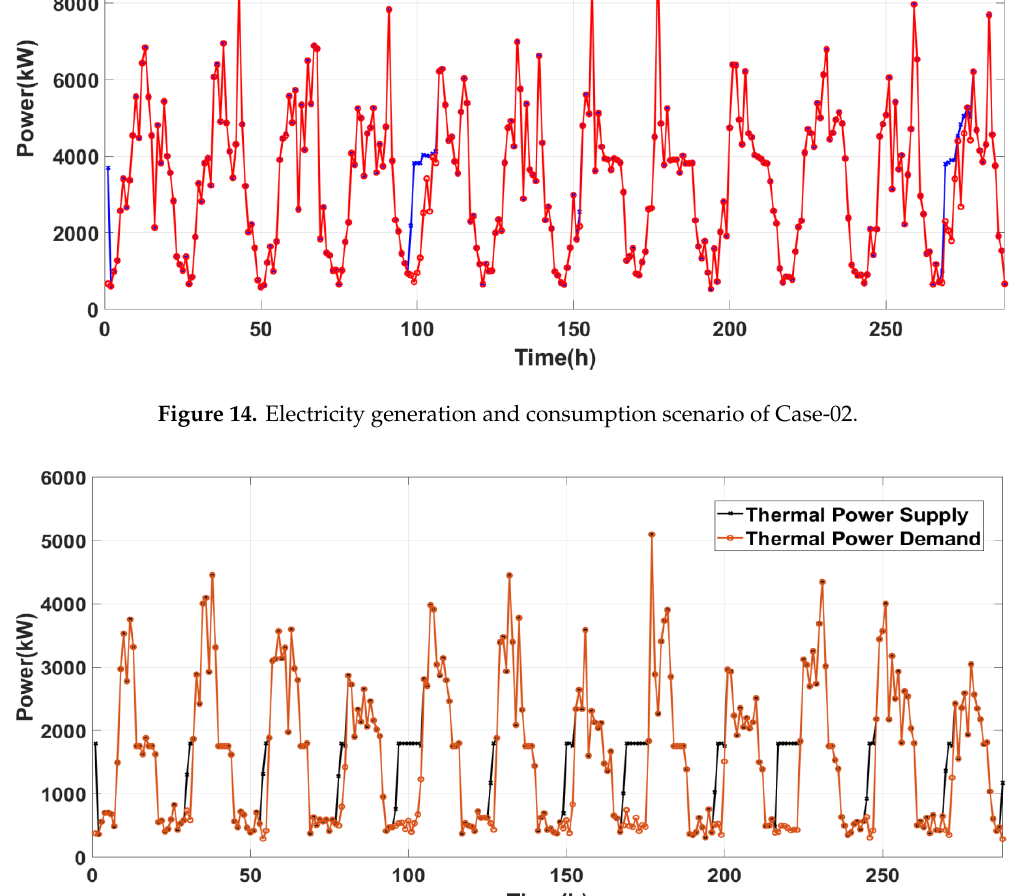
Figure 15. Thermal power generation and consumption scenario of Case-02.